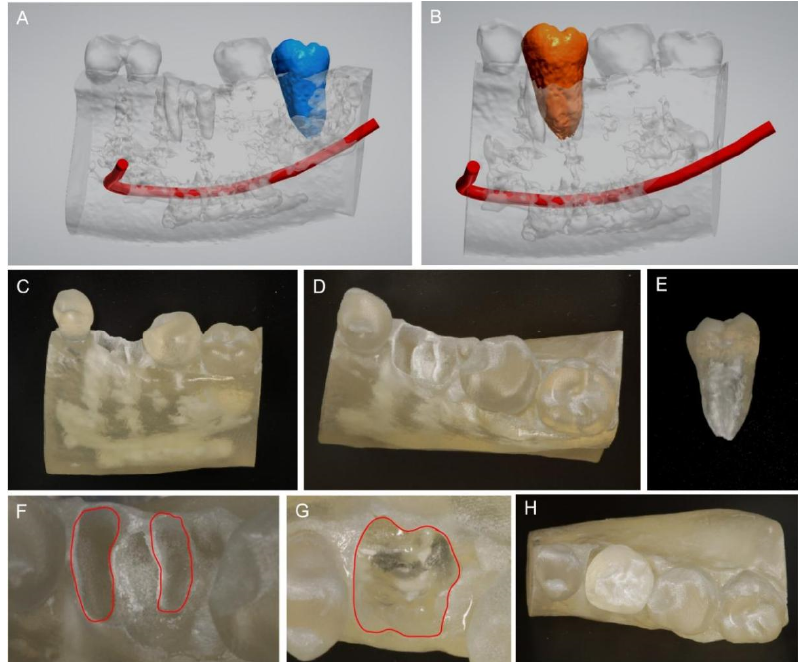
Figure 2. Digital planning and 3D-printed CARP models of the donor tooth and extraction socket. ( A ) Virtual construction of digital imaging was created using CBCT radiographs and surgical planning software (3 Shape Software, Copenhagen, Denmark). Segmentation of the donor tooth #38 (in blue). ( B ) Virtual simulation of the donor tooth in its planned position of tooth #36 (in orange). ( C , D ) The 3D-printed CARP model of the tentative extraction socket of the buccal view ( C ) and occlusal view ( D ). ( E ) The 3D-printed CARP model of the replica donor tooth #38. ( F ) Double-root outlines of tooth #36 of the tentative extraction socket are shown as a red line. ( G ) Single-root outline prepared (red line). ( H ) The replica donor tooth #38 inserted into the replica alveolar socket.